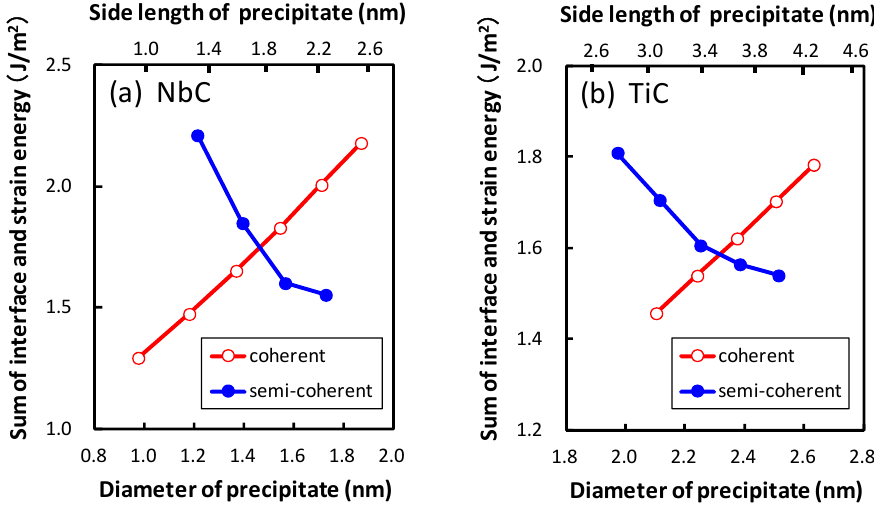
Figure 8. The dependence of diameter of the precipitate on the sum of the interface and strain energies for the coherent and semi-coherent precipitates of ( a ) NbC and ( b )